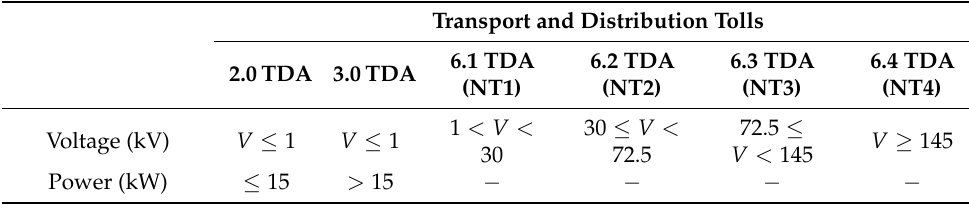
Table 2. Voltage and power limits corresponding to each transport and distribution toll.